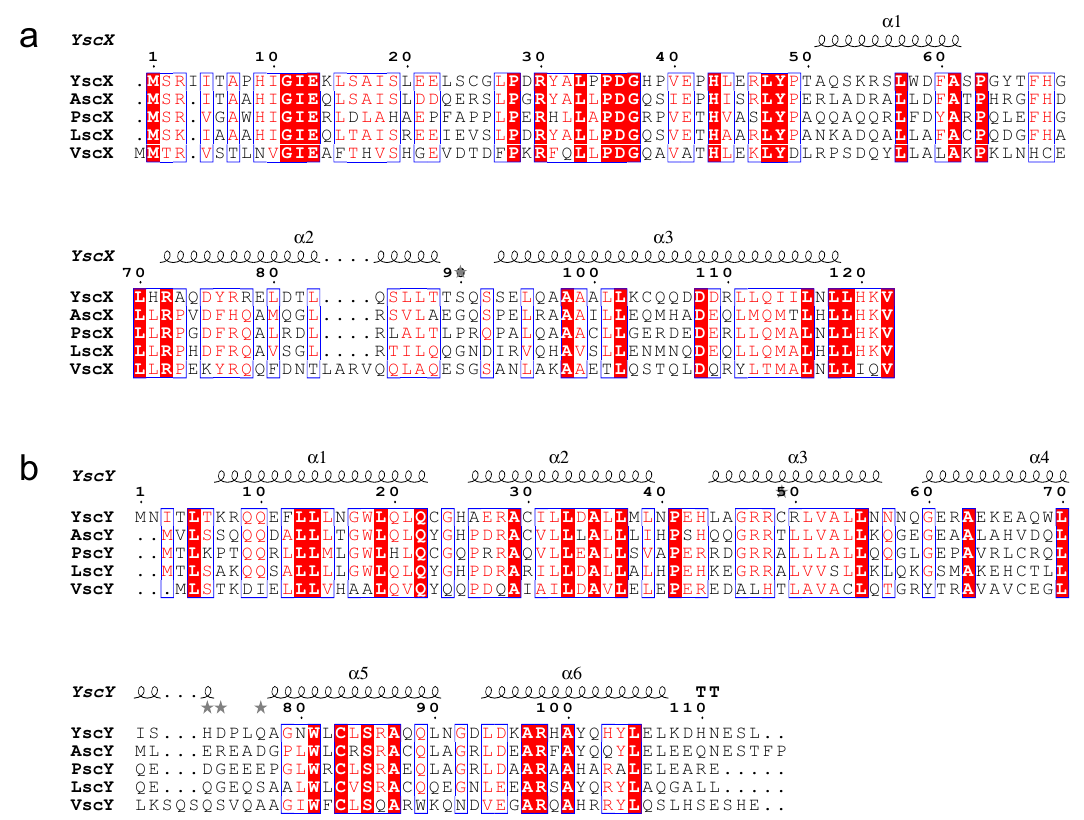
Fig. 2 Sequence alignment of SctX and SctY. a Alignment of SctX. b Alignment of SctY. Alignments were calculated using ClustalW 66 and visualized with ESPript3 (espript.ibcp.fr, 67 ). SctX and SctY sequences from Yersinia enterocolitica (YscX: AAD16820.1, YscY: AAK69217.1), Aeromonas hydrophila (AscX: AAS91814.1, AscY: AAS91815.1), Pseudomonas aeruginosa (PscX: AAY17109.1, PscY: AAY17110.1), Photorhabdus luminescens (LscX: CAE16135.1, LscY: CAE16134.1), and Vibrio parahaemolyticus (VscX: UJX28051.1, VscY: EDM61220.1) were used to generate the alignment. De fi nition of colors and symbols: red box, white character: strict identity; red character: similarity in a group; blue frame: similarity across groups; gray star: residues with alternate